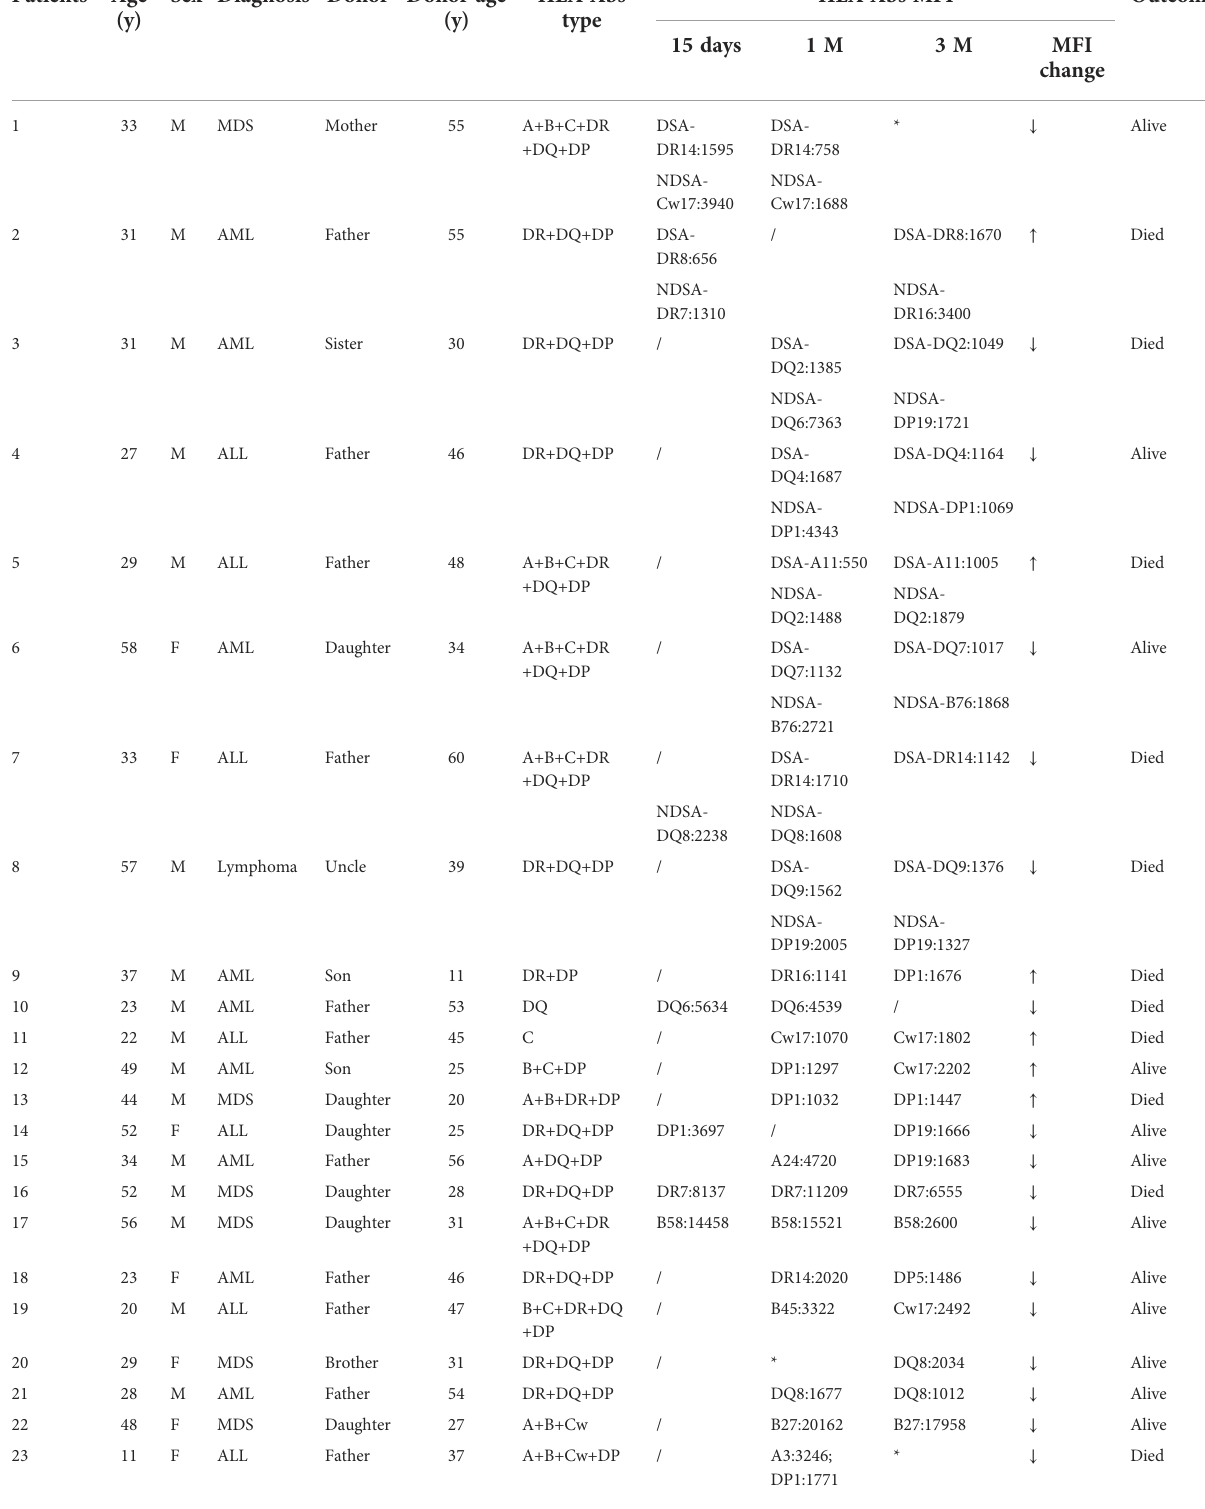
TABLE 3 Basic clinical information, antibody type and outcomes of patients with persistent de novo HLA antibodies after haplo-HSCT (n=33). Patients Age